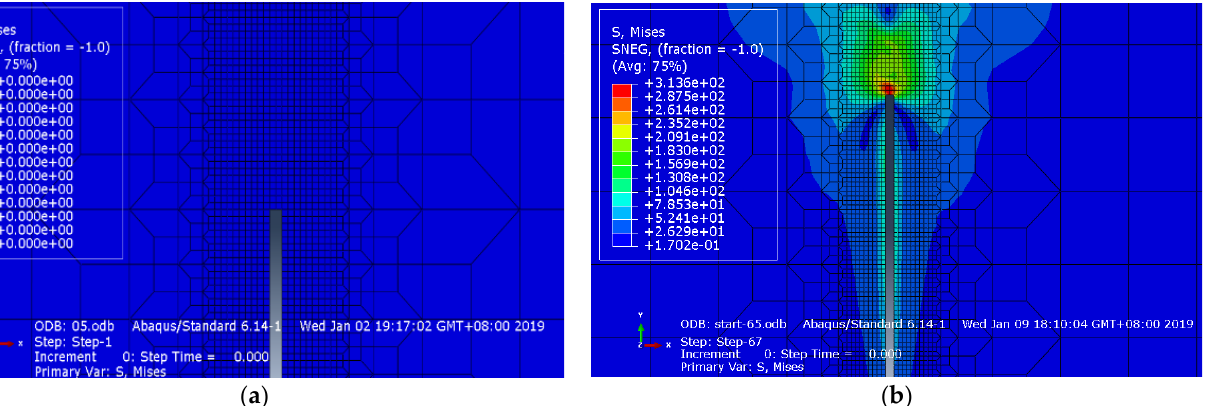
Figure 8. The initial deformation: ( a ) plate with prefabricated crack; ( b ) plate with fatigue crack (When cyclic tensile load unloading to zero).